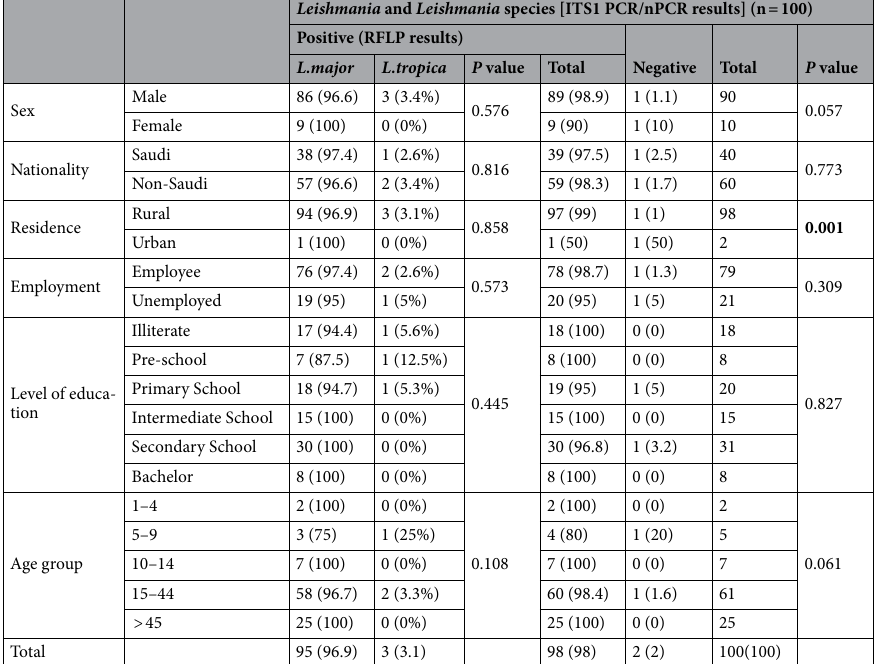
Table 5. Socio-demographic data of study individuals in association with Leishmania [ITS1 PCR/nPCR results] and Leishmania species [ITS1 PCR/nPCR-RFLP results]. Presented as number (percentage). P value is significant if > 0.05. *Preschool: Participants still did not reach school